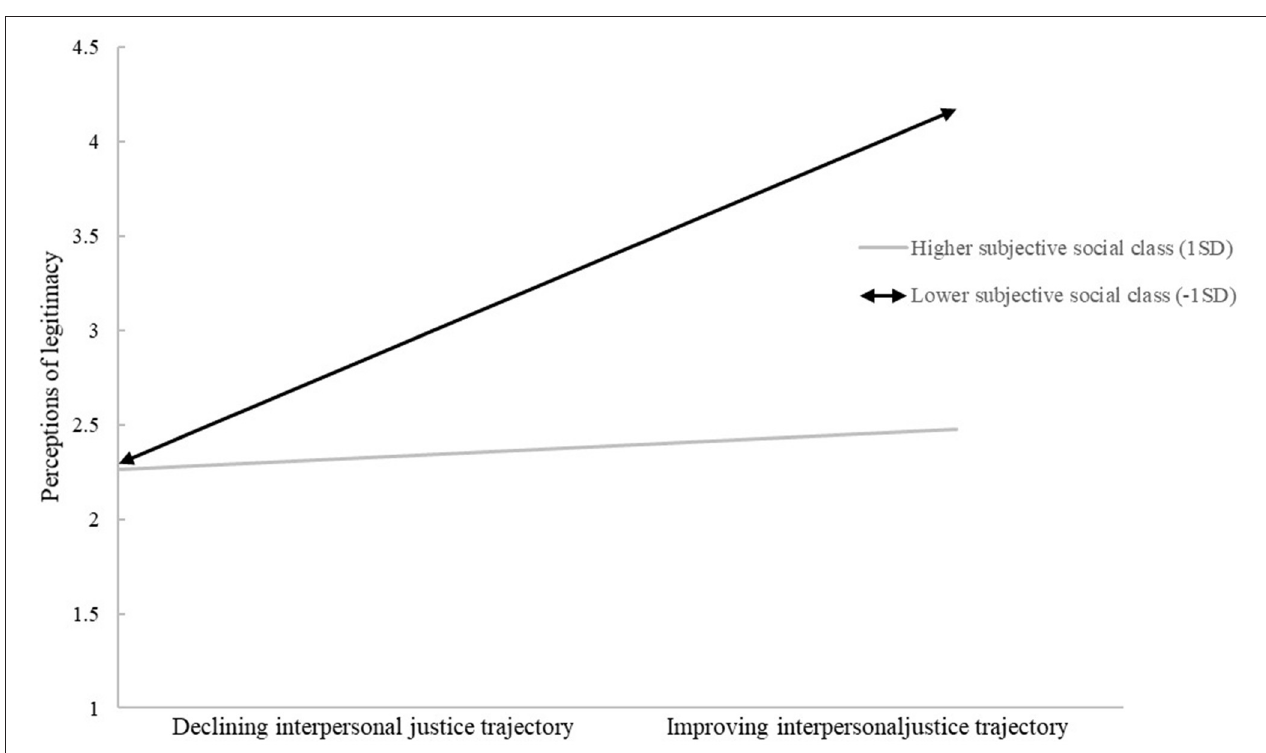
FIGURE 1 | Perceptions of legitimacy as a function of interpersonal justice trajectory and subjective social class. Means are on 5-point scales with higher scores indicating higher perceived legitimacy.